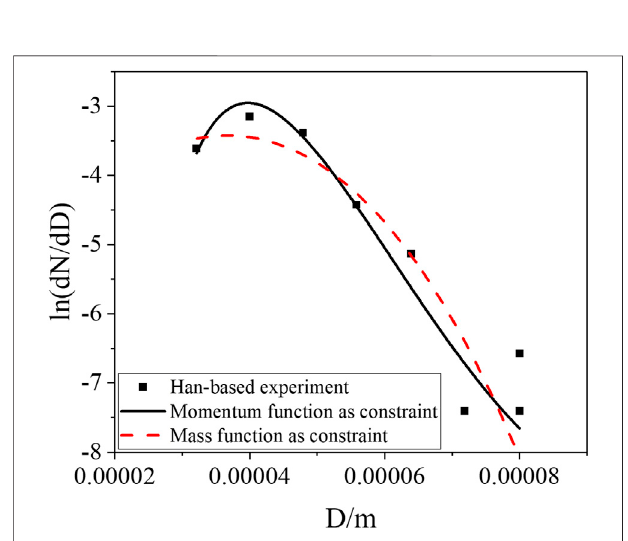
FIGURE 3 | Results of droplet size distribution of HAN-based liquid droplets under the pressure difference of 2.6